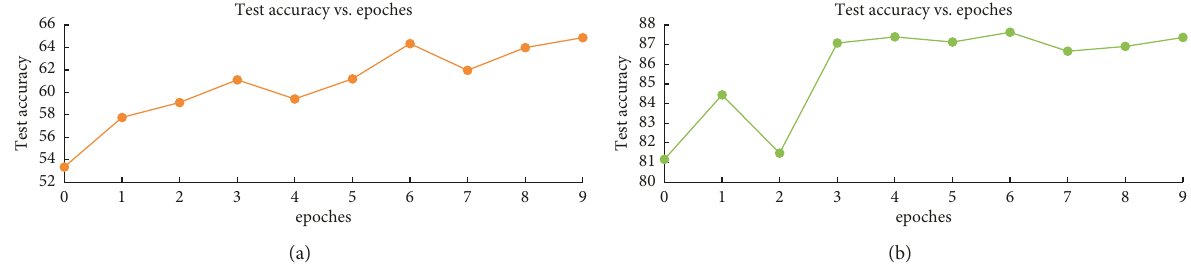
Figure 4: The accuracy of the test set: (a) literature [18] accuracy and (b) proposed model accuracy.